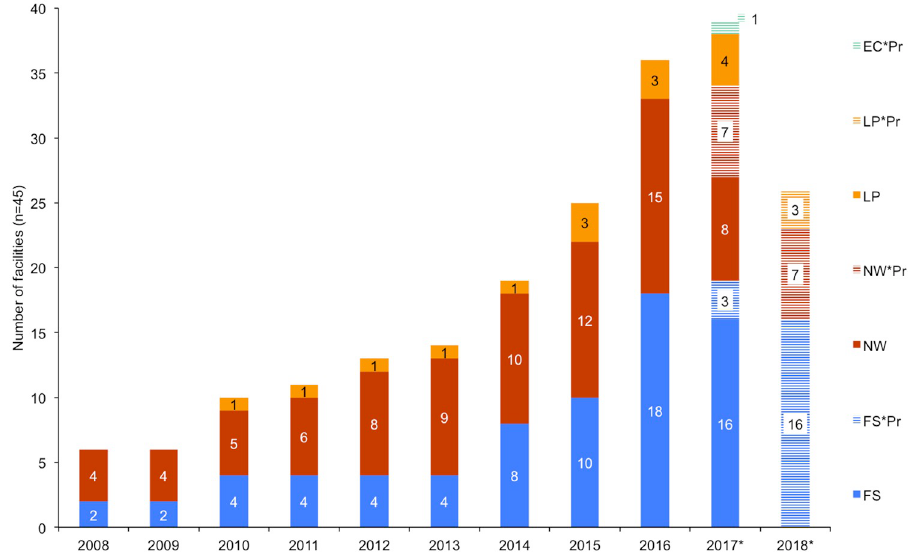
Fig 7. Annual provincial growth in the number of responding facilities saying that lion skeletons from their facility were exported to E-SEA at least once from 2008–2017 (that they were aware of). Legend: FS = Free State, NW = North West, LP = Limpopo, EC = Eastern Cape; the suffix � Pr refers to facilities predicting they would sell bones in either 2017/2018 (depending on the year they took the survey). Results correspond to Question